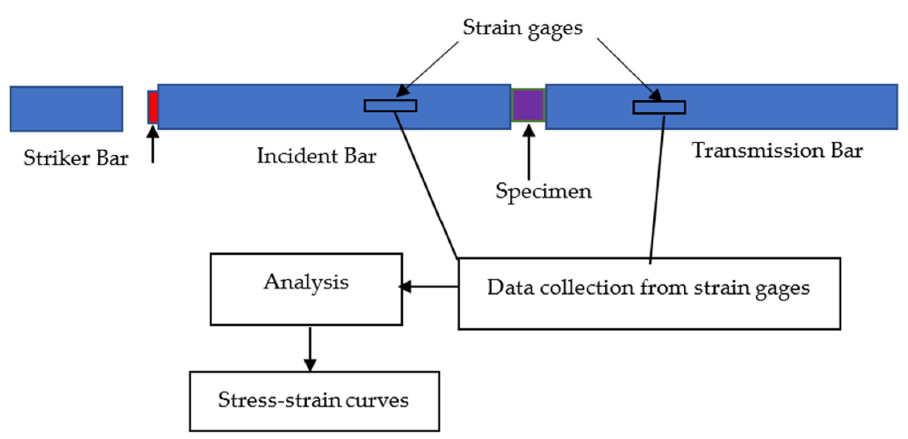
Figure 4. Schematic of conventional split Hopkinson pressure bar (SHPB) adapted from [57].